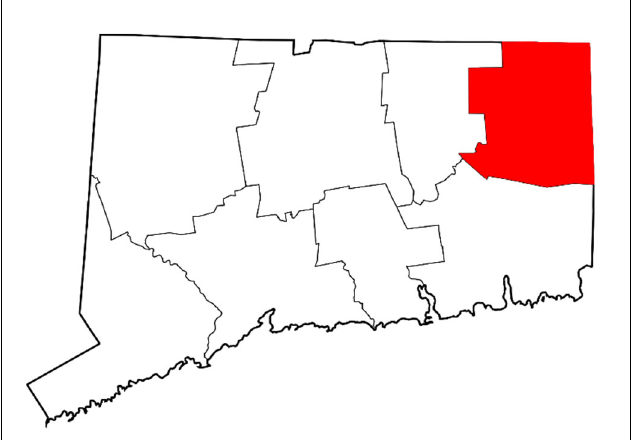
Figure 1. Windham County in the State of